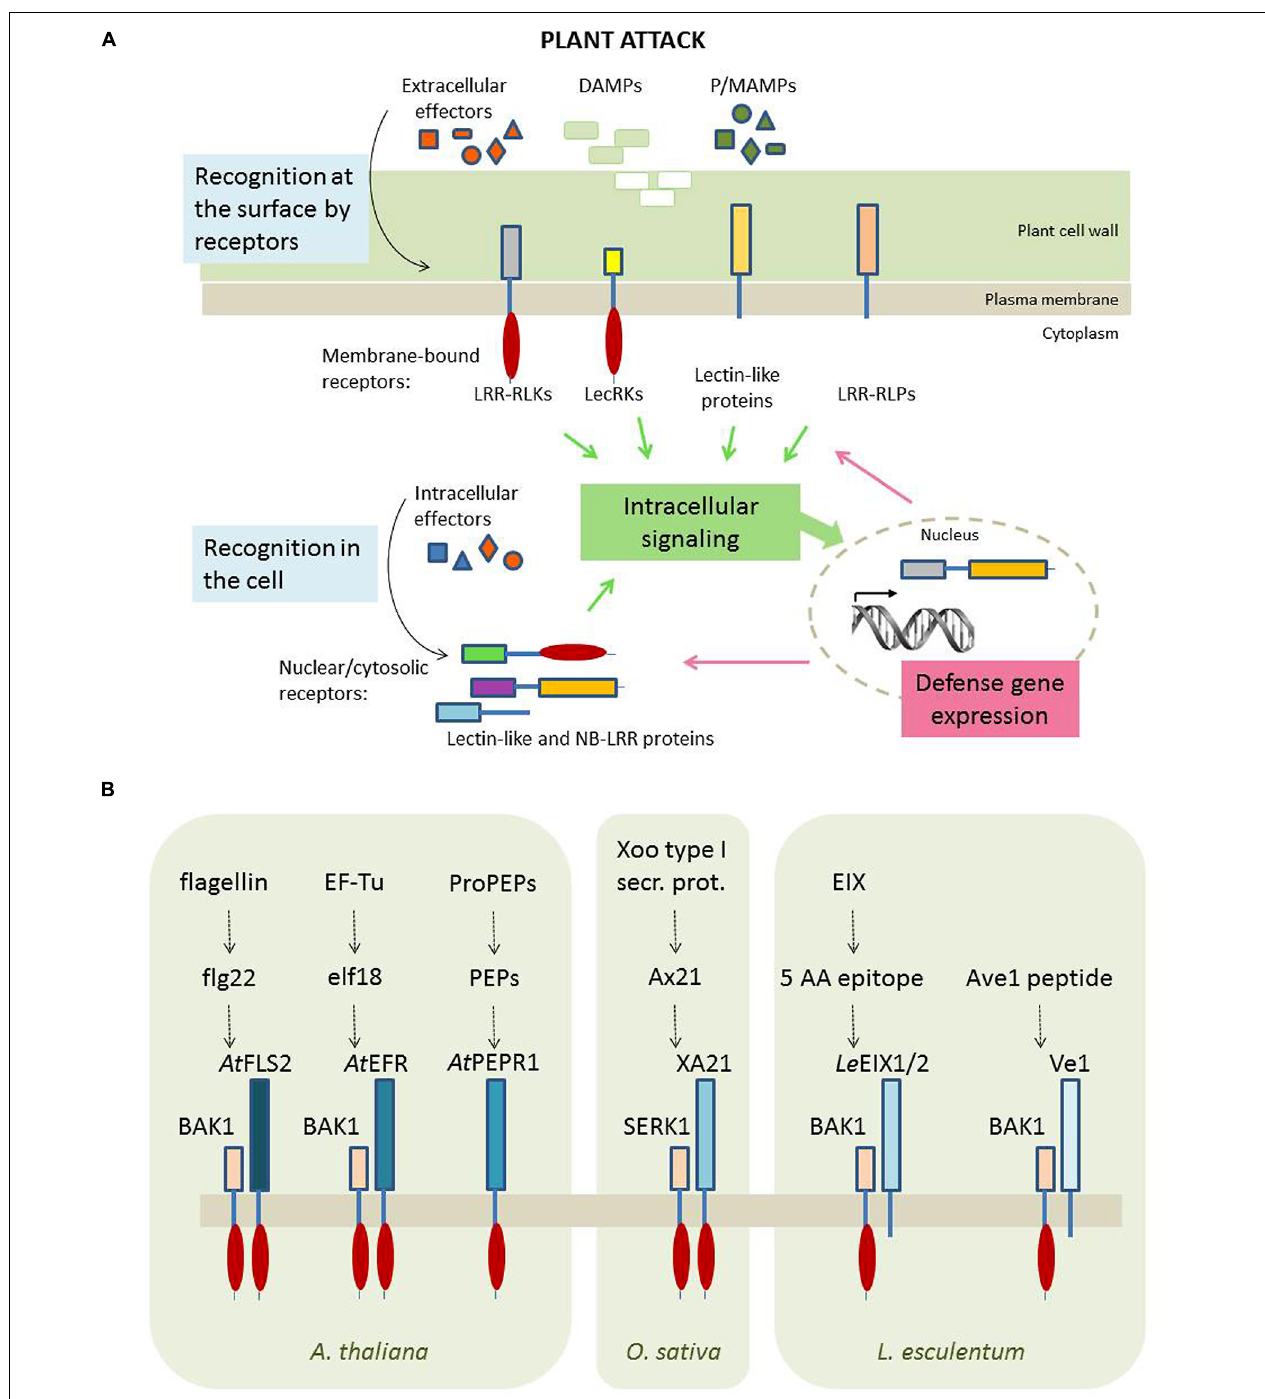
far include NB-LRR proteins as well as nucleocytoplasmic lectins. Upon ‘danger’ perception, these receptors trigger intracellular signals which ultimately will result in altered expression of defense-related genes. Legend: ellipses represent kinase domains; bars represent other protein motifs, including LRRs and lectin domains. (B) Transmembrane PRRs detect P/MAMPs through protein–protein interactions. Bars represent LRR domains, red ellipses indicate functional kinase